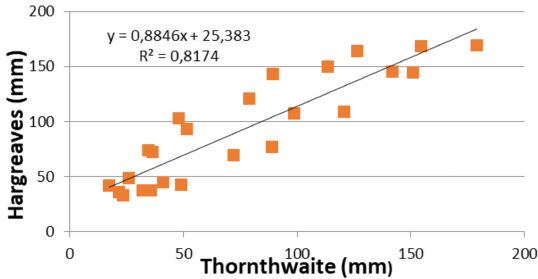
Figure 10. Comparison of the monthly PET obtained by the Thorn- thwaite and Hargreaves methods at E1 station (see Fig. 1) for the hydrological years 2014–15 and